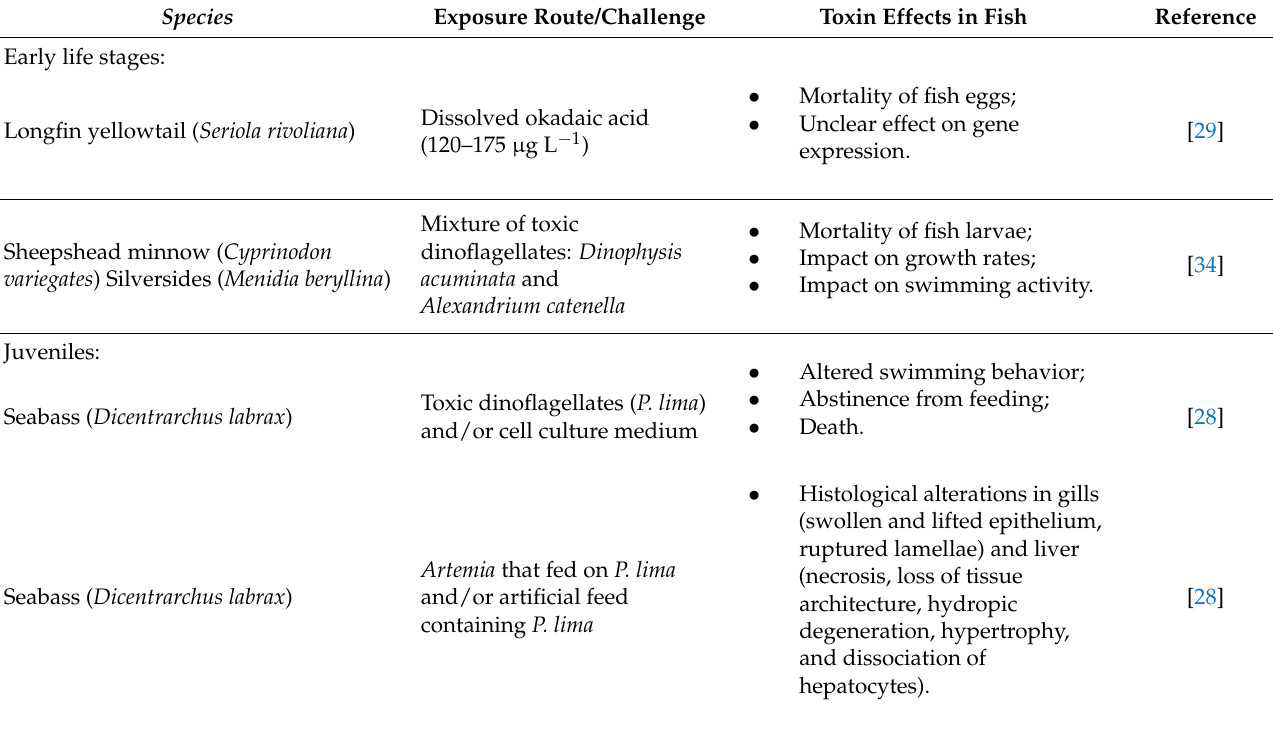
Table 1. Effects of okadaic acid and dinophysistoxins in marine/estuarine fish. Species Exposure Route/Challenge Toxin Effects in Fish Reference Early life